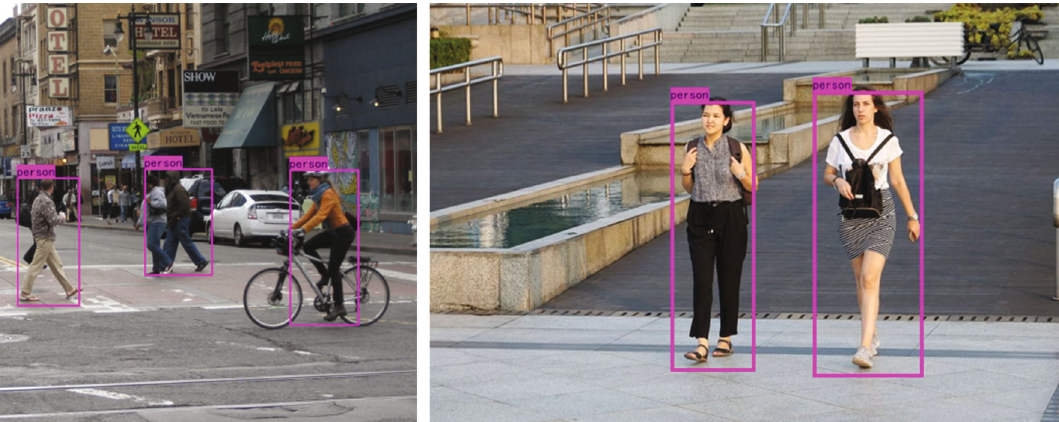
Figure 4: Human body detection e ff ect display.